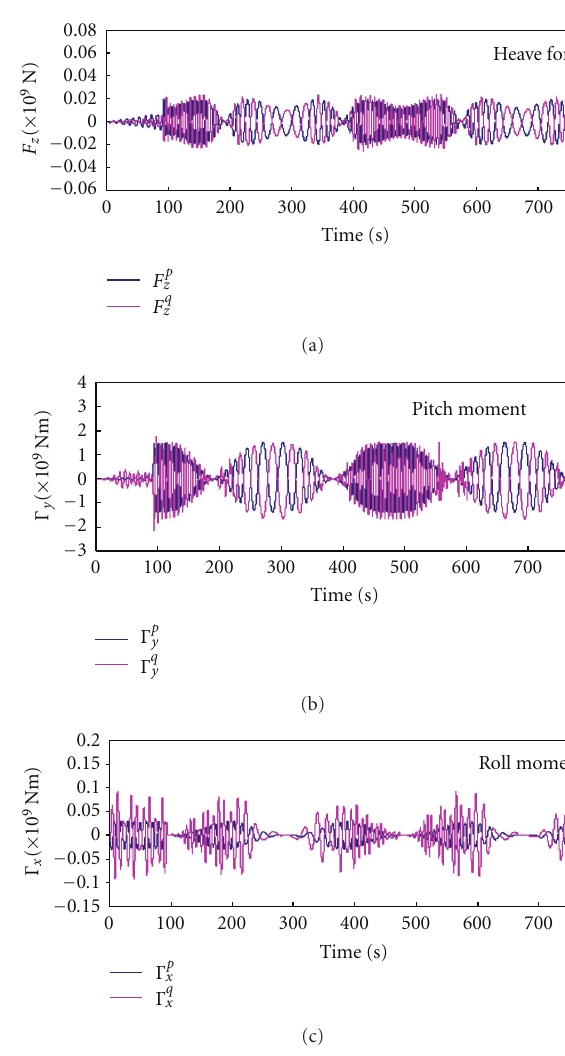
Figure 2: Same as Figure 1, but with the encounter frequency fixed to ω en = ω sea (Case 2). Figure 3: Same as Figure 1 (Case 1), but the forces are calculated by the new algorithm defined in (28) and